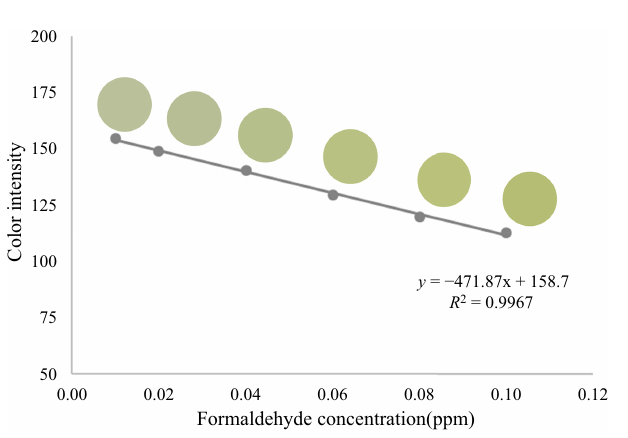
Figure 4. Color intensity and test duration obtained from each concentration